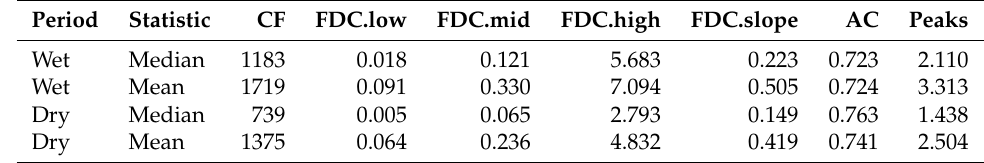
Table 3. Summary of hydrological signatures for the observed catchment flow